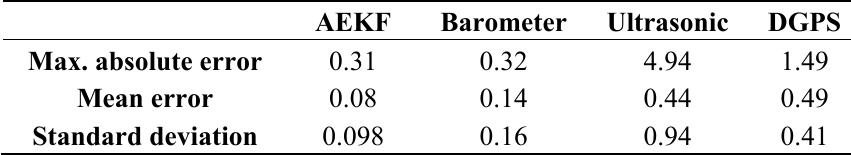
Table 2. Altitude accuracies for AEKF and each sensor (in